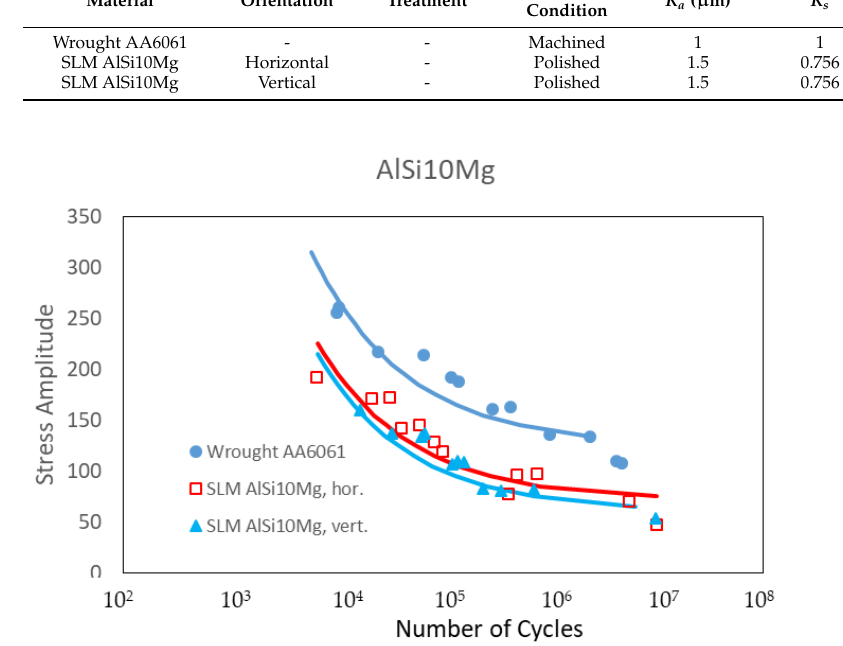
Figure 6. Fatigue behaviours of wrought and AM Ti6Al4V. Table 9. Surface finish and microstructural factors for AlSi10Mg ( 𝜎 0 = 125 MPa).